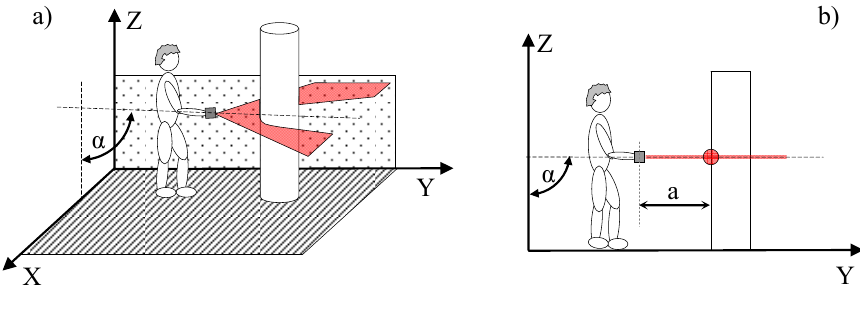
Figure 5 . Representation of the electronic white cane operating in frontal mode: (a) general representation and (b) distance to the main